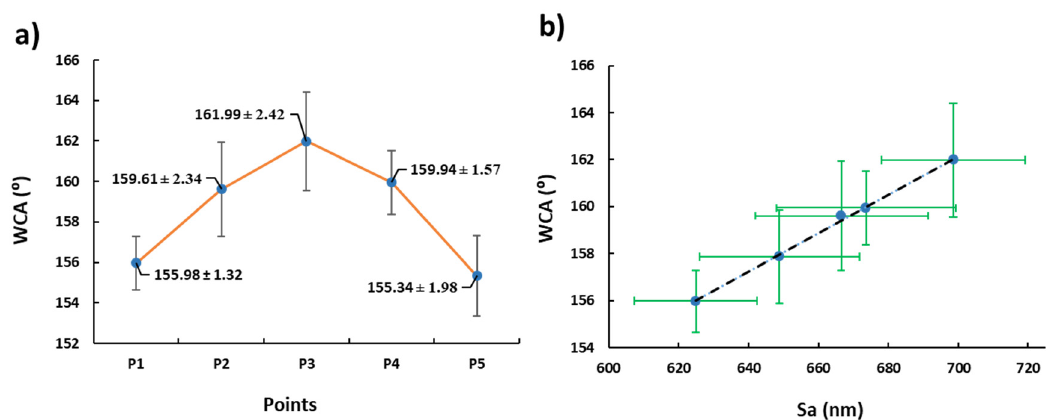
Figure 13. ( a ) Evolution of the water contact angle (WCA) and its standard deviation as a function of the operational points (P1, P2, P3, P4, and P5). ( b ) Behavior of the WCA as a function of the average surface roughness (Sa).